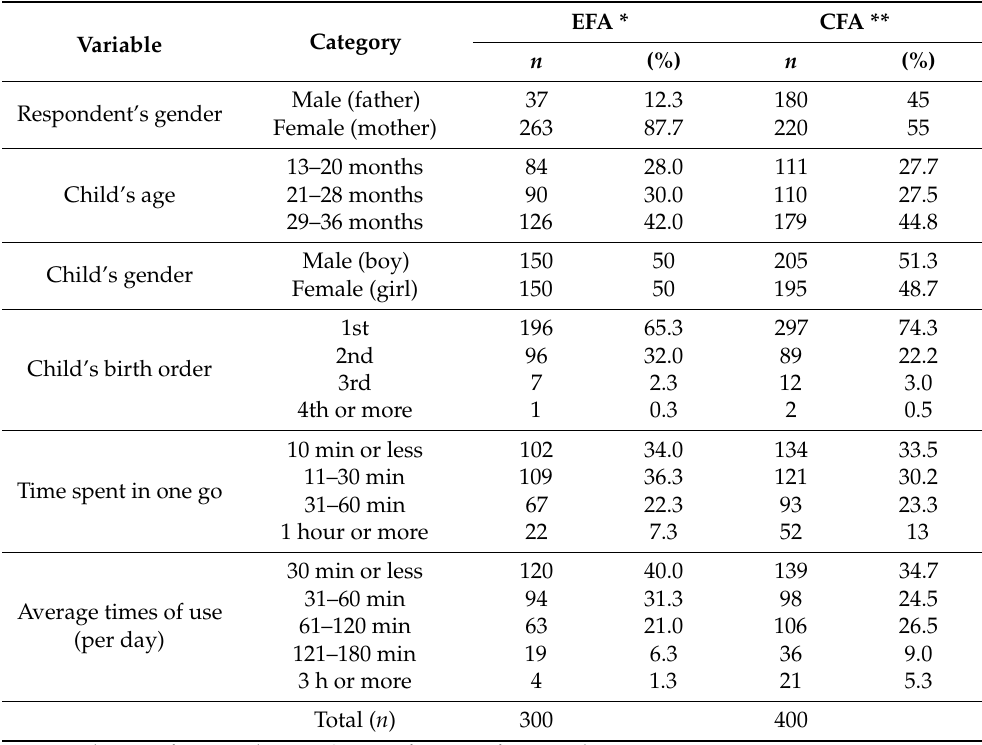
Table 1. Respondents’ general characteristics ( n =